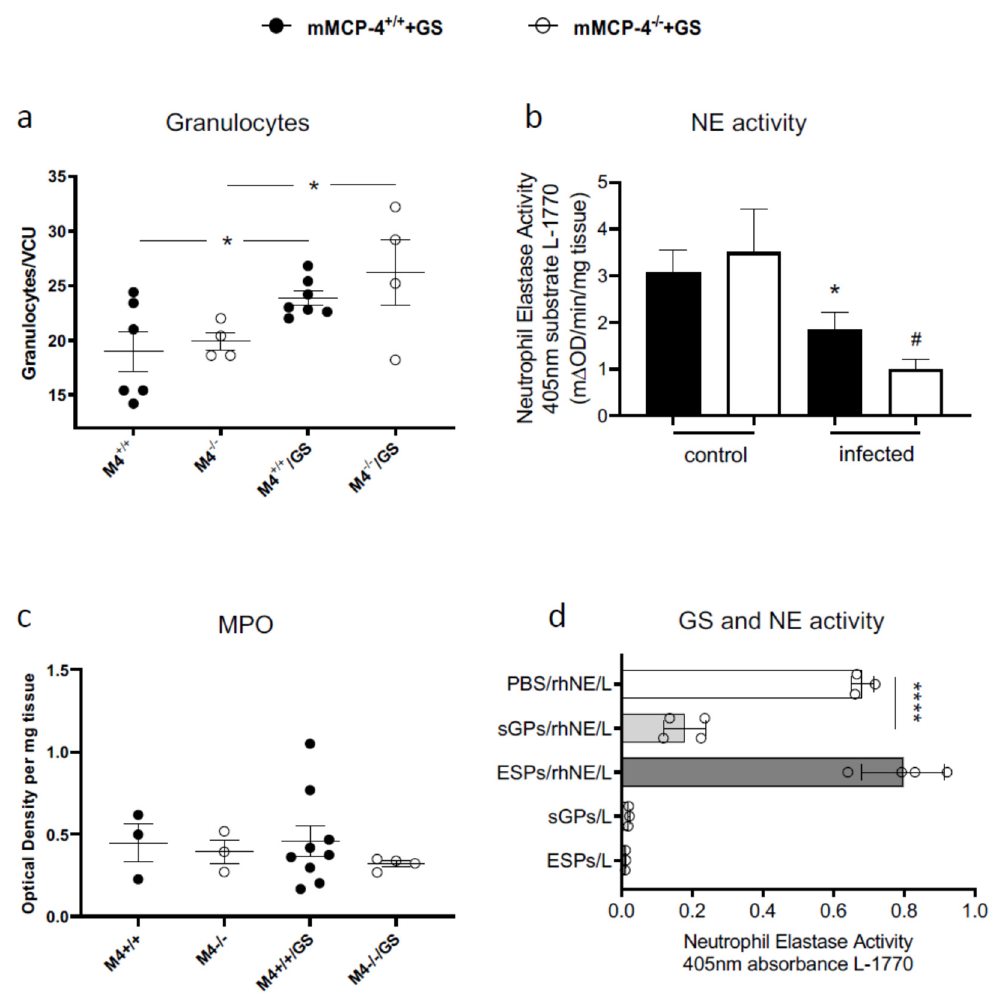
Figure 3. Increased granulocyte counts and reduced neutrophil elastase (NE) activity in the small intestine during infection with Giardia intestinalis . ( a ) Granulocytes in the villi and crypt area were counted on H&E-stained small intestinal sections from non-infected and > 18-week-old mice 8 dpi. Intestinal NE activity ( b ) and MPO activity ( c ) in 8 dpi mMCP-4 +/+ and mMCP-4 − / − littermate mice and in non-infected littermate mice. ( d ) The activity of recombinant human NE was challenged with sGPs or ESPs. VCU, villi crypt unit. sGPs, soluble Giardia proteins. ESP, Giardia excretory secretory proteins. L, the NE substrate L-1770. *, # represent p < 0.05 for infected vs. non-infected mice and **** represent p < 0.0001 for sGPs/rhNE vs. PBS/rhNE.